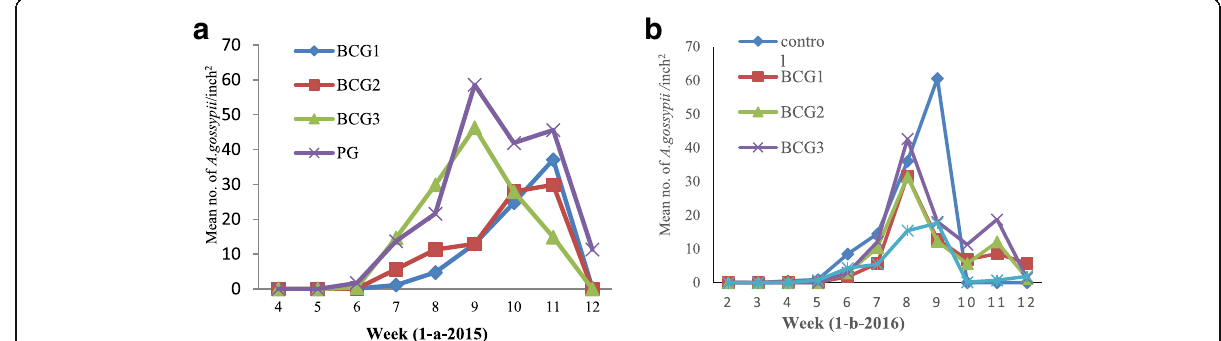
Fig. 1 a , b Mean numbers of A . gossypii /square inch in the treatments of controlling the aphid on cucumber in greenhouses in the two summer plantations, 2015 and